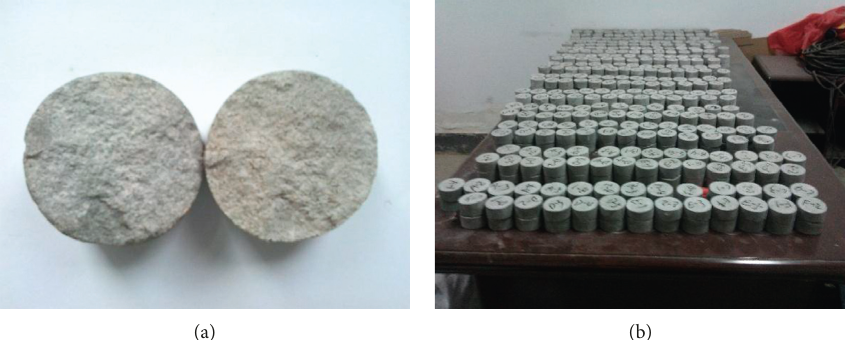
Figure 6: Subsamples of natural rough rock joint surfaces. (a) Comparison between original samples and subsamples; (b) parts of subsamples.